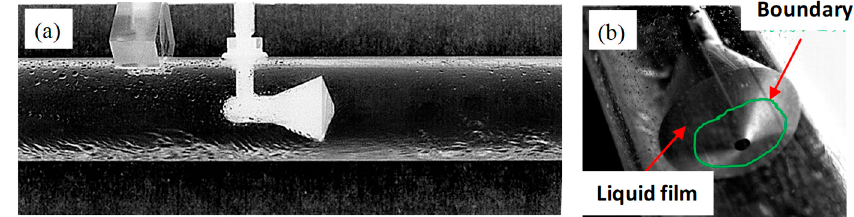
Figure 18. Liquid distribution on cone observed in experiment ( a ) front view of flow through cone sensor; ( b ) liquid film around the low pressure tapping (the video is available in Supplementary Materials: Video S5).